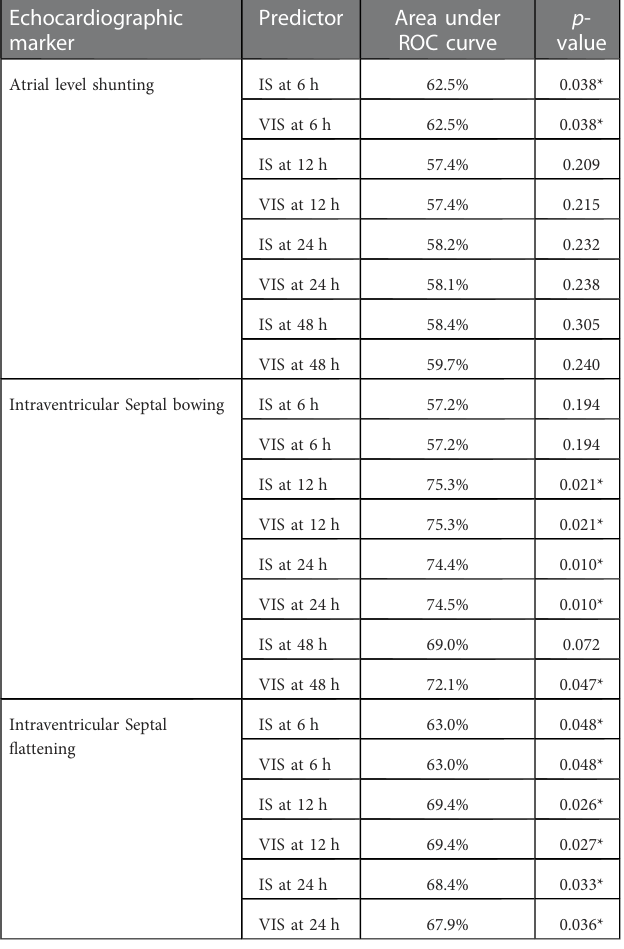
TABLE 3 Associations of iS/VIS obtained in fi rst 48-HOL with echocardiographic markers in 1st postnatal echocardiogram. Echocardiographic marker